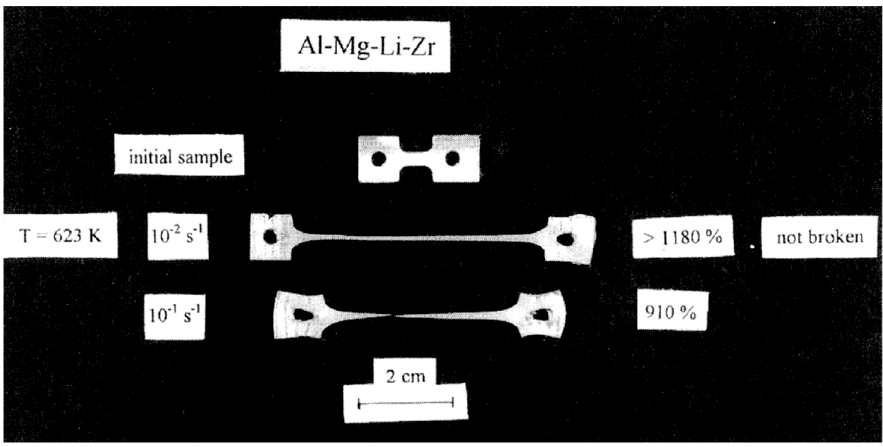
Figure 8. Examples of high strain rate superplasticity in an Al–Mg–Li–Zr alloy pulled at strain rates of 10 − 2 and 10 − 1 s − 1 [36].